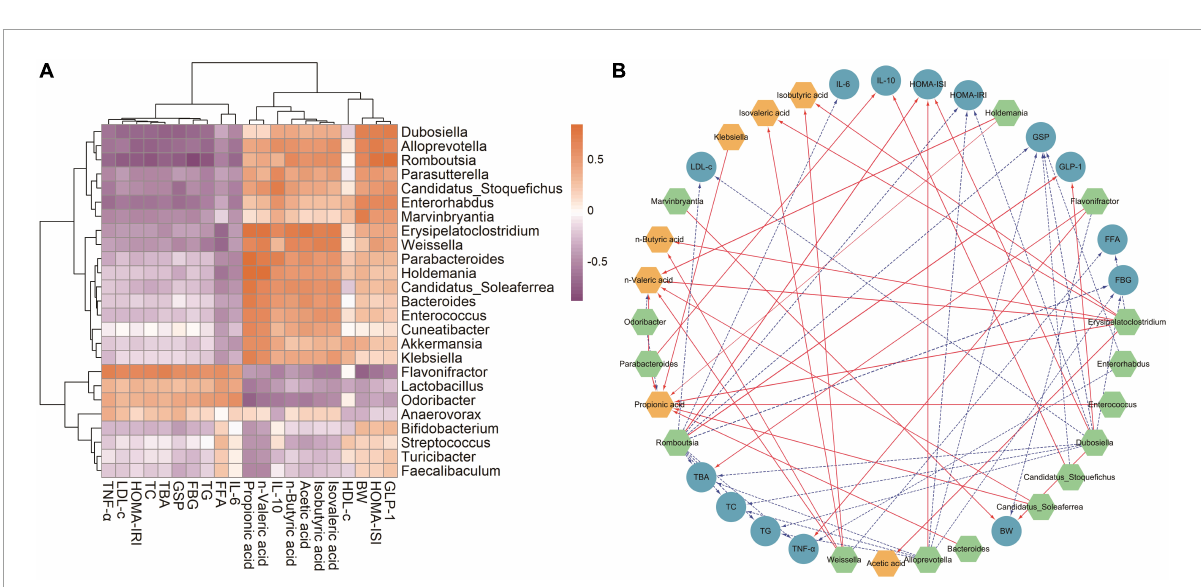
FIGURE9 Statistical Spearman’s correlations between the characteristic intestinal microbes and the biochemical indexes in T2DM mice. (A) Hierarchical clustering heatmap of the correlation between the characteristic intestinal microbes and the biochemical indexes. The chocolate and orchid nodes represent the positive and negative correlation coefficient, respectively; the color shades indicate the strength of correlation. (B) Visualization of the correlation network. Green, blue, and yellow nodes represent the characteristic intestinal microbes, biochemical indexes, and fecal SCFAs, respectively; the solid red lines and dotted blue lines indicate the correlation coefficient > 0.6 ( p < 0.01) and the correlation coefficient < –0.6 ( p < 0.01), respectively. The linewidth reflects on the strength of